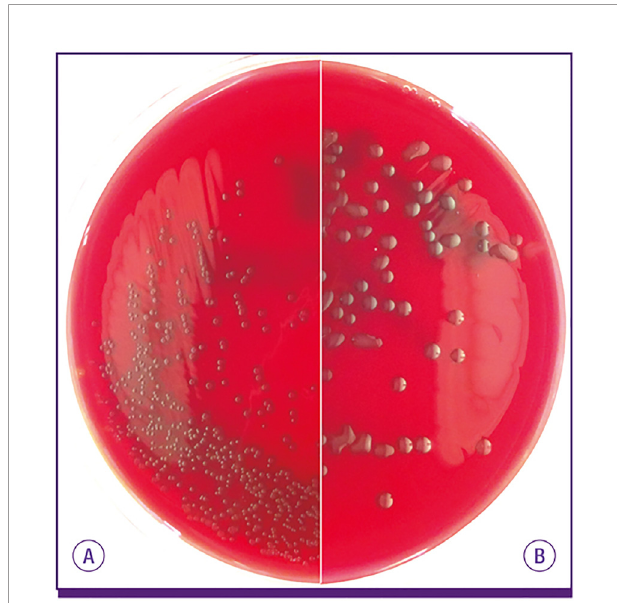
FIGURE 1 | S. pneumoniae isolates expressing most capsuletypes make (A) smallround colonies similar to doughnuts on blood agar plate, but (B) serotype 3 and 37 pneumococci develop characteristically large mucoid colonies. From Songet al.